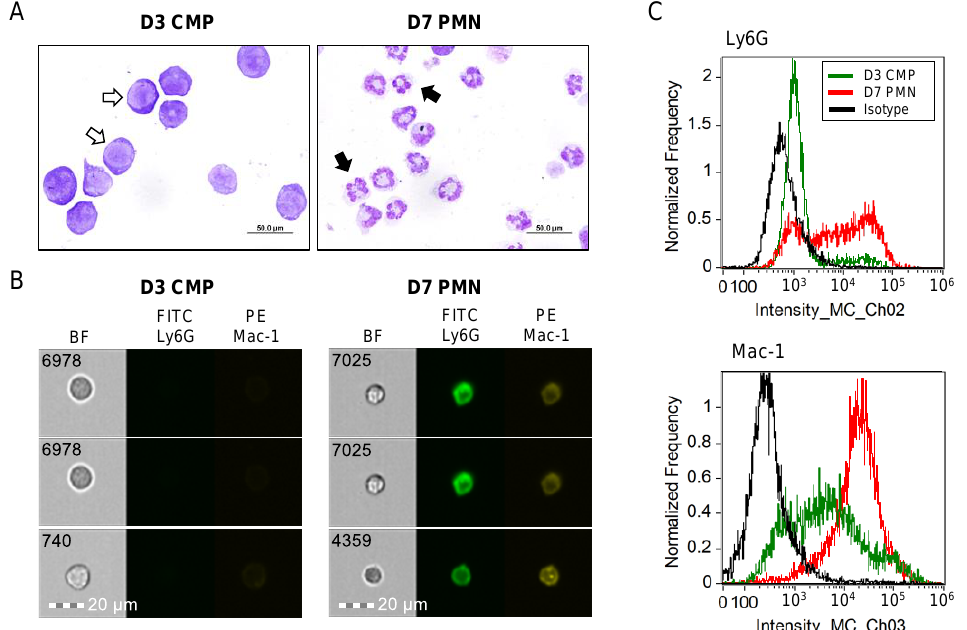
Figure 1. Maturation characteristics of neutrophils derived from mouse bone marrow for chemotaxis assays. ( A ) Shown are images of Wright–Giemsa-stained cells generated from ex vivo culture of bone marrow at the common myeloid progenitor stage (after 3 days of culture, D3 CMP), or the terminally differentiated stage (polymorphonuclear neutrophils after 7 days of culture, D7 PMN). CMP exhibit characteristic high N/C ratios (open arrows), whereas PMN have lobulated or ring-shaped nuclei (closed arrows). ( B ) Images are depicted of CMP and PMN labeled with anti-Ly6G or anti-Mac-1 antibodies with fluorescence tags (FITC or PE, respectively), each obtained using imaging flow cytometry. ( C ) Graphs generated from imaging flow cytometry indicate quantities of cells with either Ly6G or Mac-1 expression at each stage of differentiation, with the appropriate isotype used as the negative control.